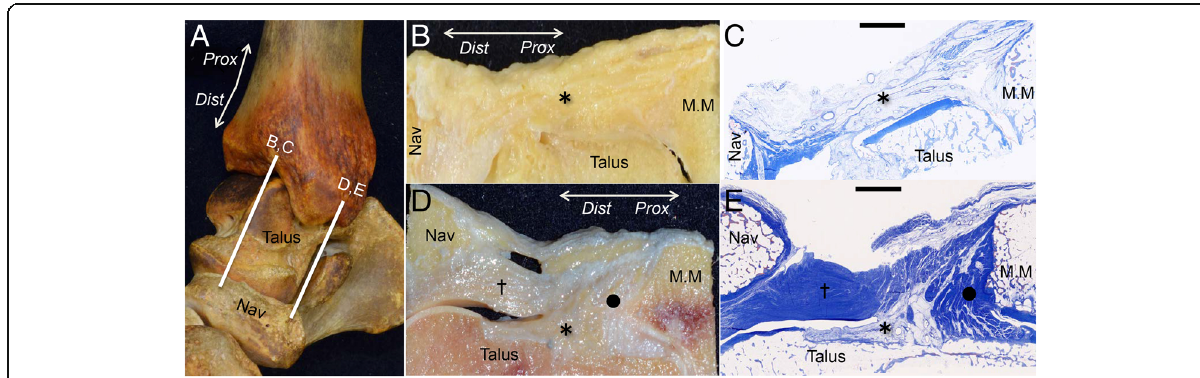
Fig. 6 Histological analysis of the joint continuous capsule. a The bone model of the right medial ankle shows the locations of the anterior section ( b , c ) and anteromedial section ( d , e ). b and d show the macroscopic views of ( c ) and ( e ), which were stained with Masson ’ s trichrome, respectively. b , c At the anterior part of the ankle, the fatty tissue of the continuous capsule (asterisk) covered the ankle and talonavicular joints. d , e At the anteromedial part of the medial ankle, the fibrous tissue (black circle) connected between the medial malleolus and the medial talus. The fatty tissue (asterisk) occupied the space between the fibrous and the cartilaginous tissues. The cartilaginous tissue (dagger) covered the talus and connected the medial malleolus and the medial navicular. Prox, proximal; Dist, distal; Nav , navicular; MM , medial malleolus; scale bar, 5